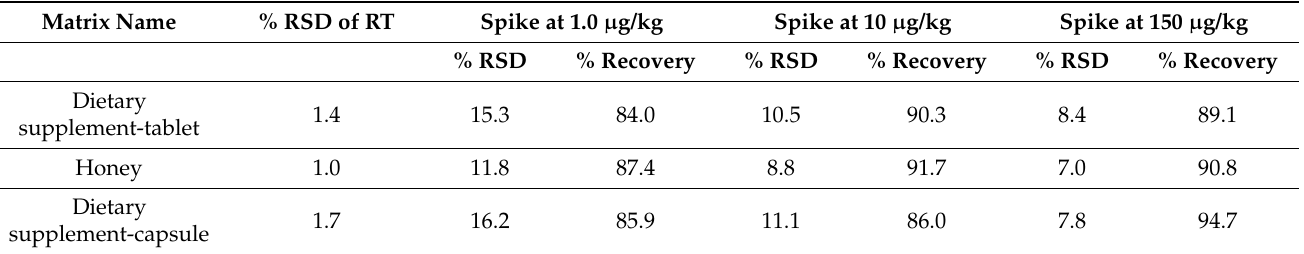
Table 8. Accuracy and Precision on day 2